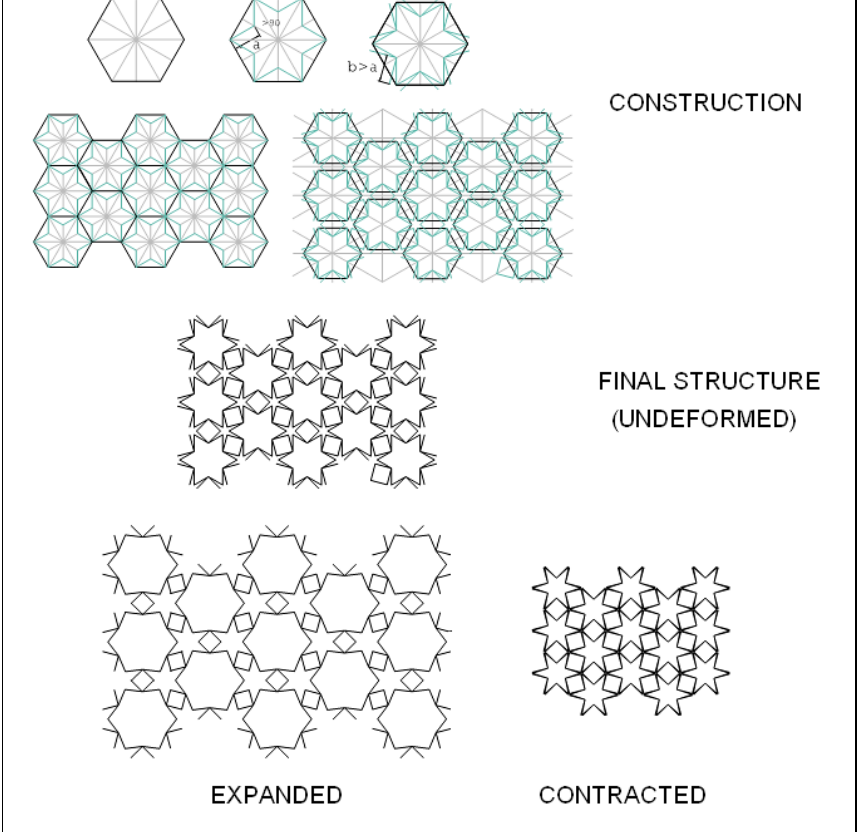
Figure 11. Auxetic structure